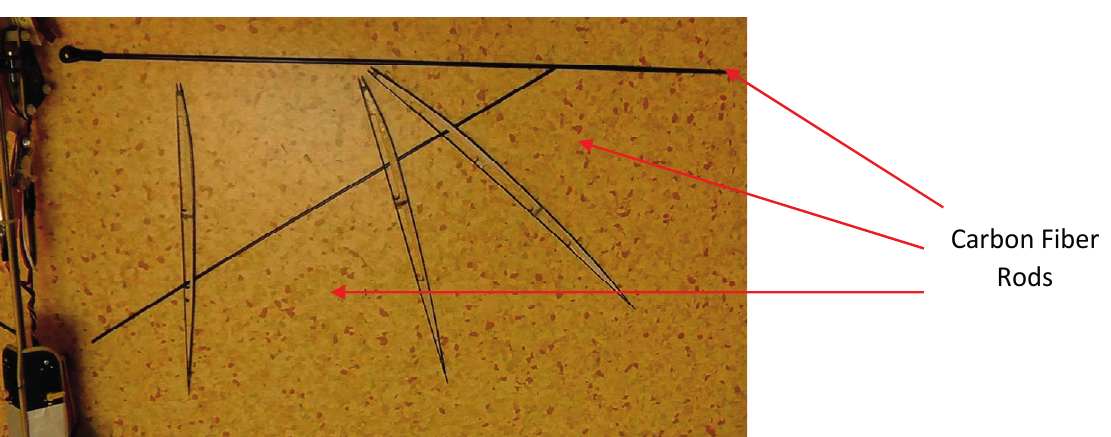
Figure 17. View of wing skeletal structure—one